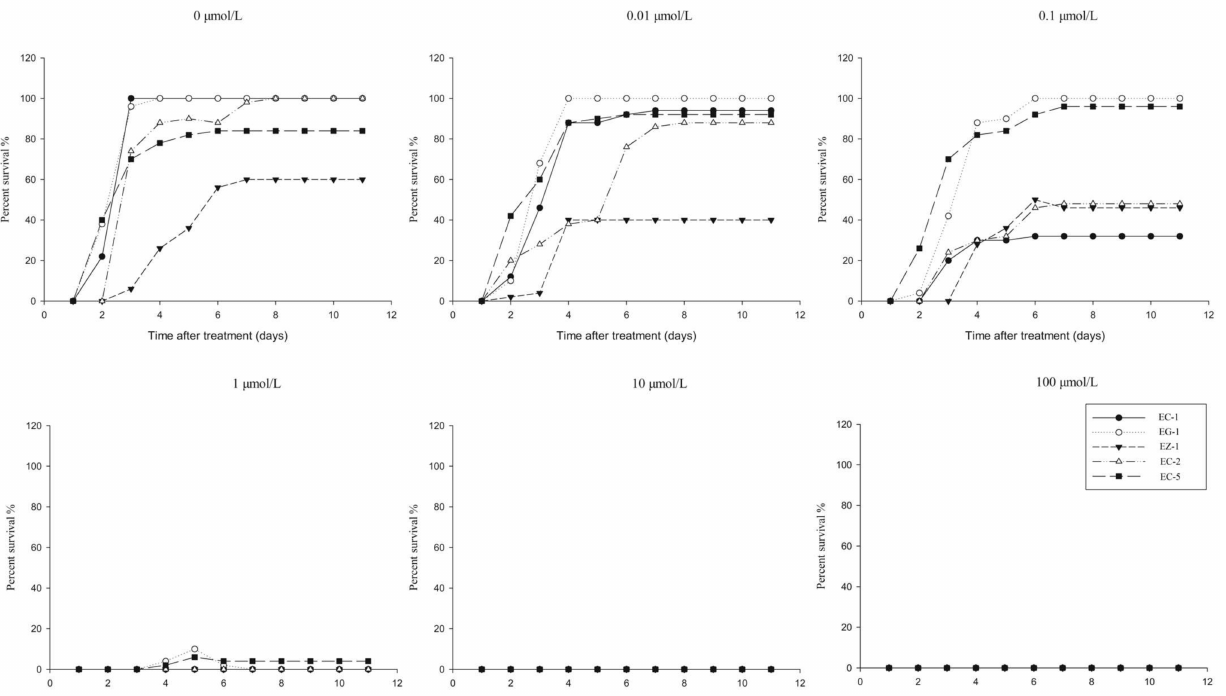
Figure 2. Percentage of daily survival of various groups at different metamifop concentrations